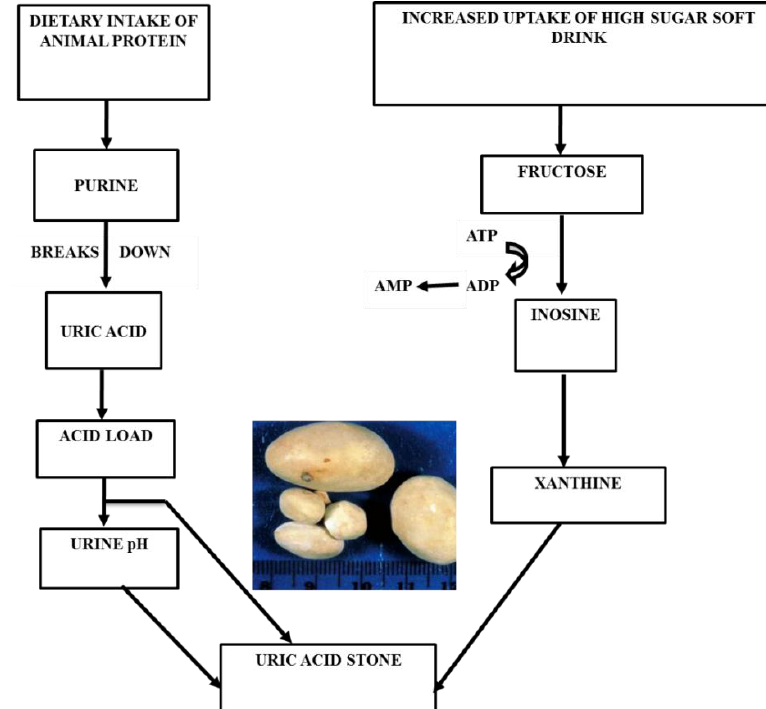
Figure 3. Uric acid stone formation with food habits.